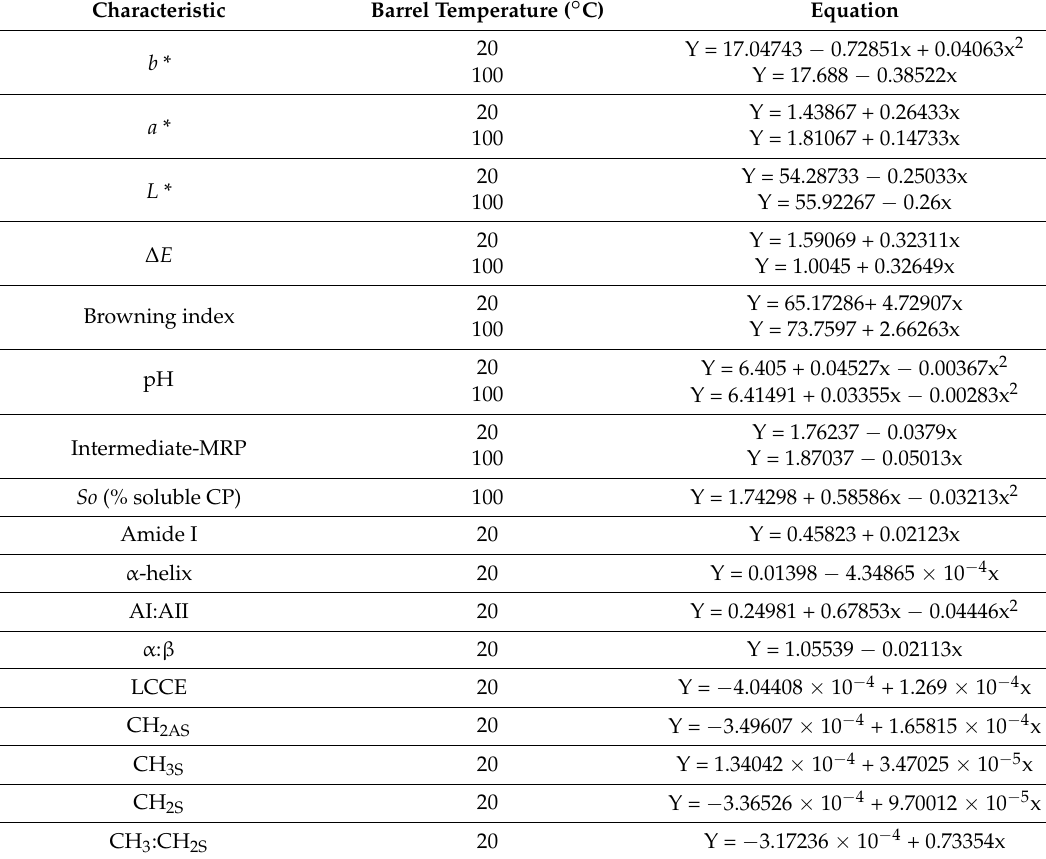
Table A2. Linear and polynomial equations to describe the effects of increasing barrel dry heat (20 and 100 ◦ C) and moist heat pressure duration on Maillard reaction product formation and protein and lipid-related molecular structure of canola